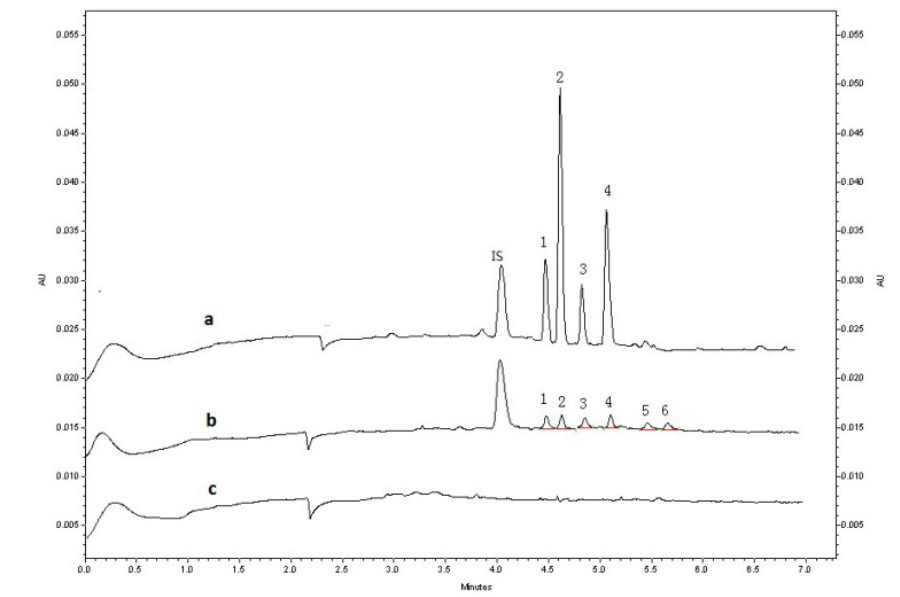
Figure 5. Typical electropherograms: ( a ) test sample of human treated with rac -MRT 0.5 h after the dose of 30 mg; ( b ) blank plasma spiked with 1ng/mL (LLOQ) rac -MRT, rac -DMR, rac -8-OHM and 20 ng/mL IS; ( c ) blank plasma. Peaks: (1) ( − )- R -DMR; (2) ( − )- R -MRT; (3) (+)- S -DMR; (4) (+)- S -MRT; (5) ( − )- R -8-OHM; (6) (+)- S